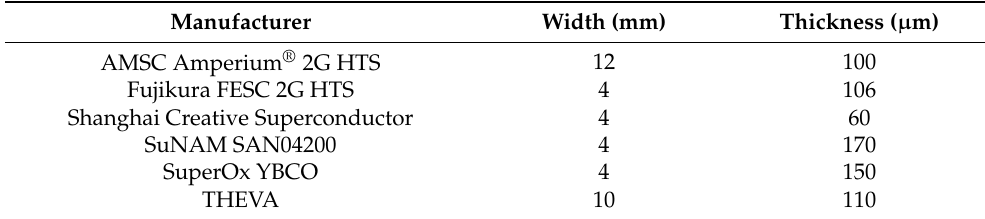
Table 1. Geometrical properties of HTS tapes used for quench probability estimation in the ANN